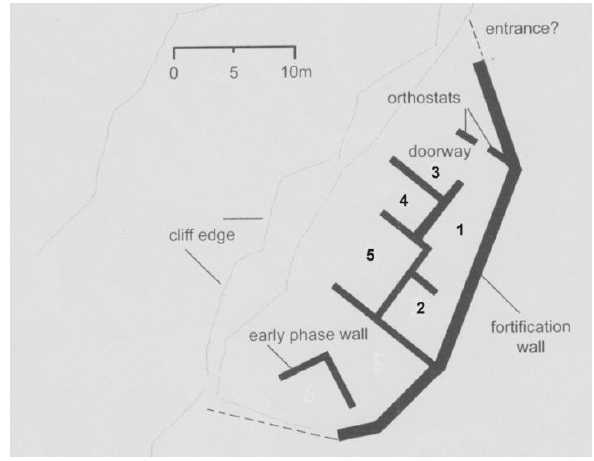
Figure 1. Agios Antonios Chomatas Site 9 groundplan